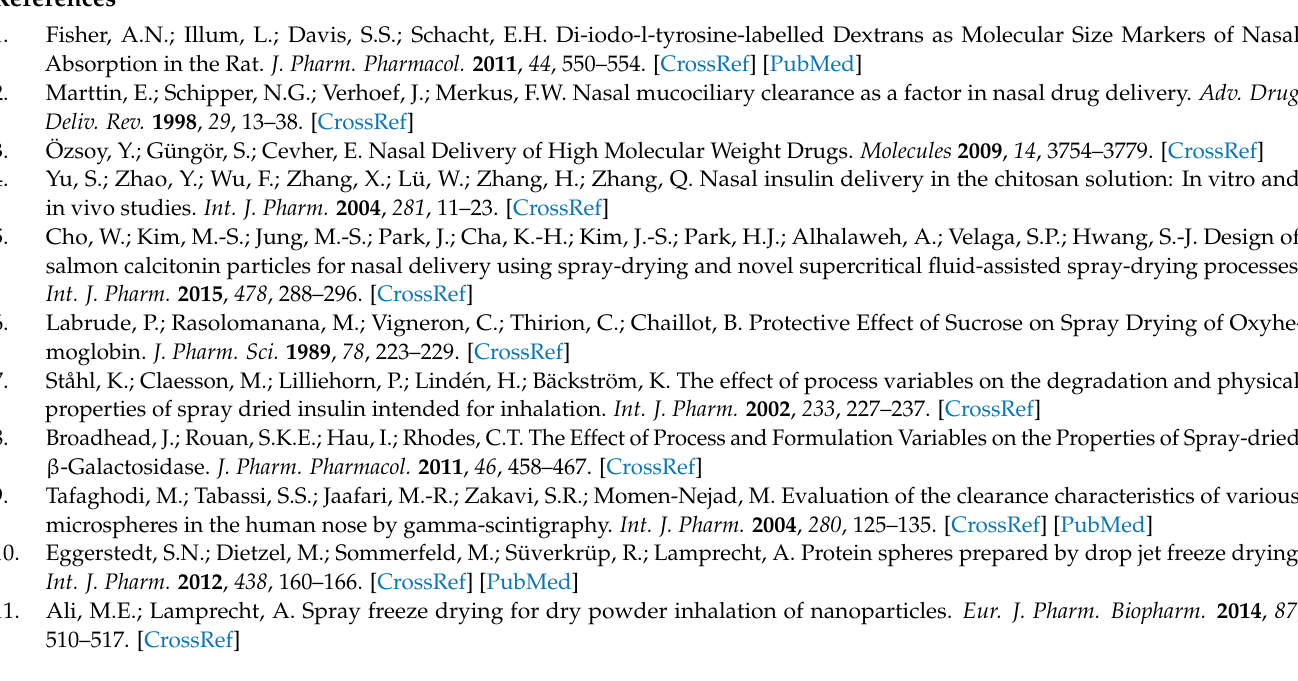
chamber; Figure S2: Custom made device for nasal administration of the particles to rats; Figure S3: Residual moisture content of the formulations after production, and 1, 3 and 6 months after SFD; Figure S4: The particle size distribution diagram of SFD particles with insulin and sodium tauro- cholate measured after insufflation through the device by dynamic image analysis using a Camsizer X2 instrument ( N = 3); Figure S5: Images of the intact spherical SFD particles (above) and fractured pieces (below) after insufflation through the device captured by the camera of the Camsizer X2 instrument; Table S1: TG analysis results of the formulations kept at − 20 ◦ C 1, 3 and 6 months after SFD ( n = 3); Table S2: SEC analysis results of the formulations kept at − 20 ◦ C 1, 3 and 6 months after SFD ( n =